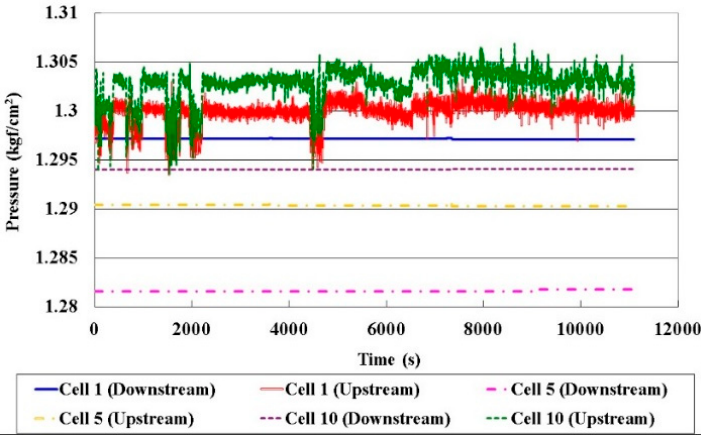
Figure 11. Comparison of local pressures in different cells.